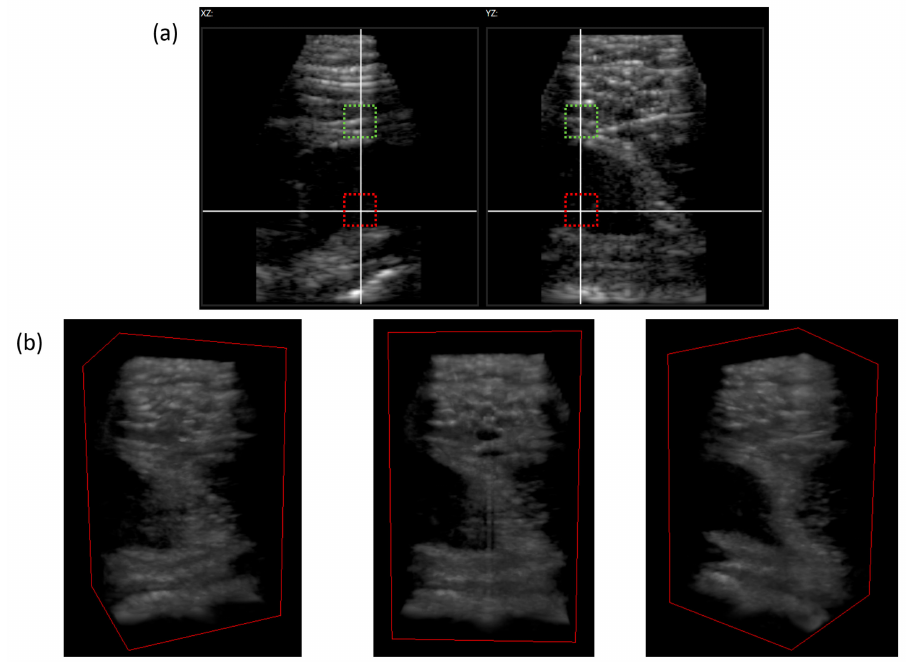
Figure 17. Volumetric imaging of an In Vivo human bladder using our 26 × 39 matrix array: orthogonal XZ, YZ plane ( a ); volume rendering of the full volume at different angles ( b